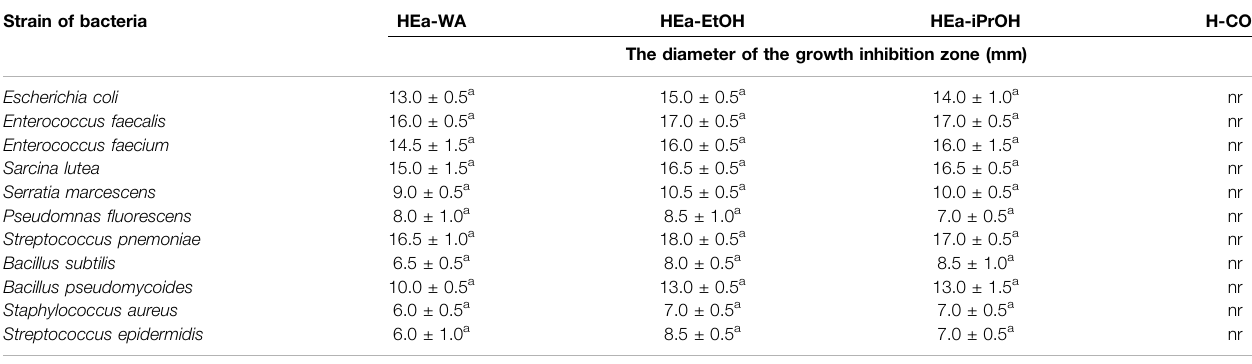
TABLE 4 | Effect of all hydrogels on inhibiting the growth of selected bacteria. Strain of bacteria HEa-WA